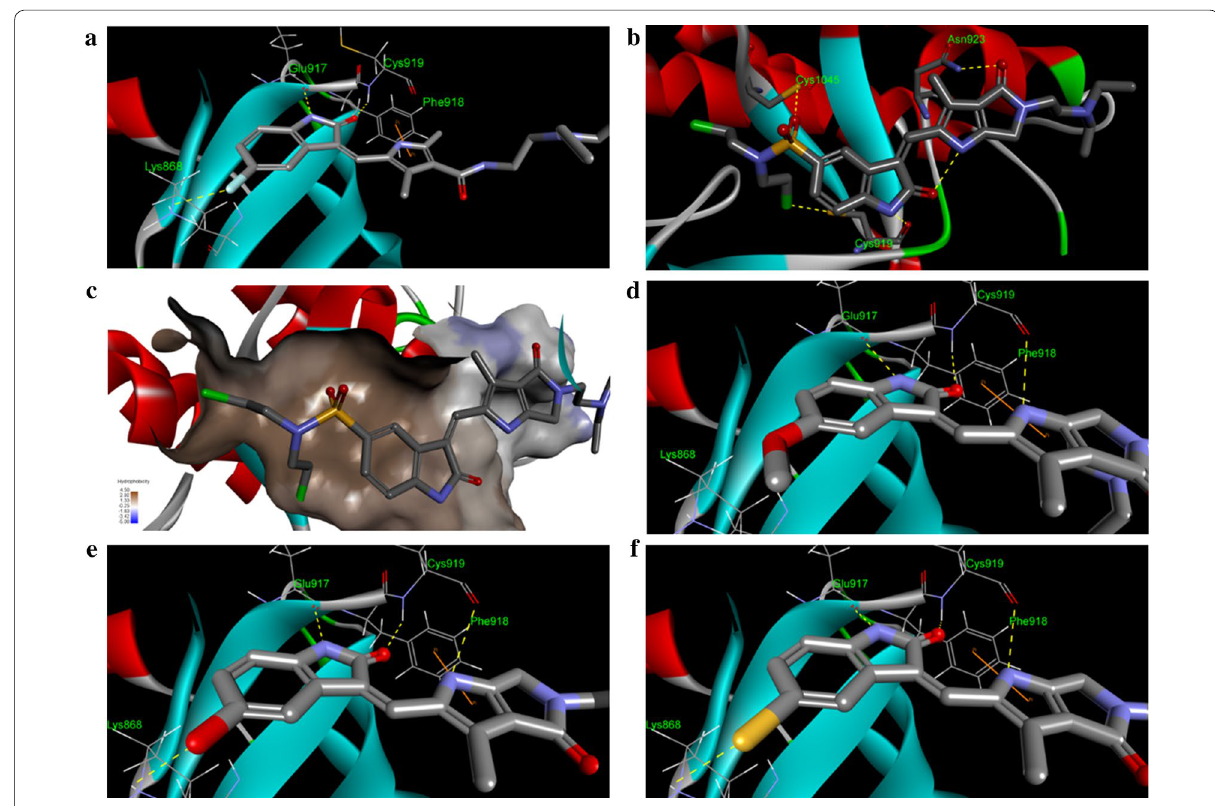
Fig. 6 Sunitinib, 7 , and 13 – 15 are docked into the active site of VEGFR‑2 (PDB ID: 4AGD) in 3‑dimentional structure. a Sunitinib in VEGFR‑2; b 7 in VEGFR‑2; c 7 in VEGFR‑2 (the active site of VEGFR‑2 was shown in hydrophobicity maps); d 13 in VEGFR‑2; e 14 in VEGFR‑2, f 15 in VEGFR‑2. Compounds are showed in sticks ; hydrogen bonds are shown as dashed yellow line ; pi–pi interaction is shown in orange line ; shades of brown indicate regions of high hydrophobicity; shades of white indicate regions of neutral, shades of blue indicate regions of low